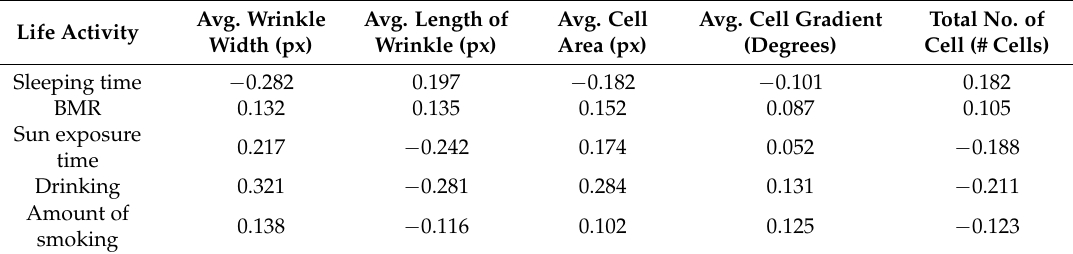
Table 2. Pearson correlation coefficient (subject 1).